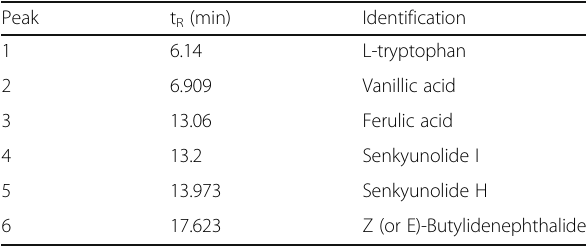
Table 2 Chemical components identified from Radix Angelicae Sinensis by HPLC-ESI/MS n